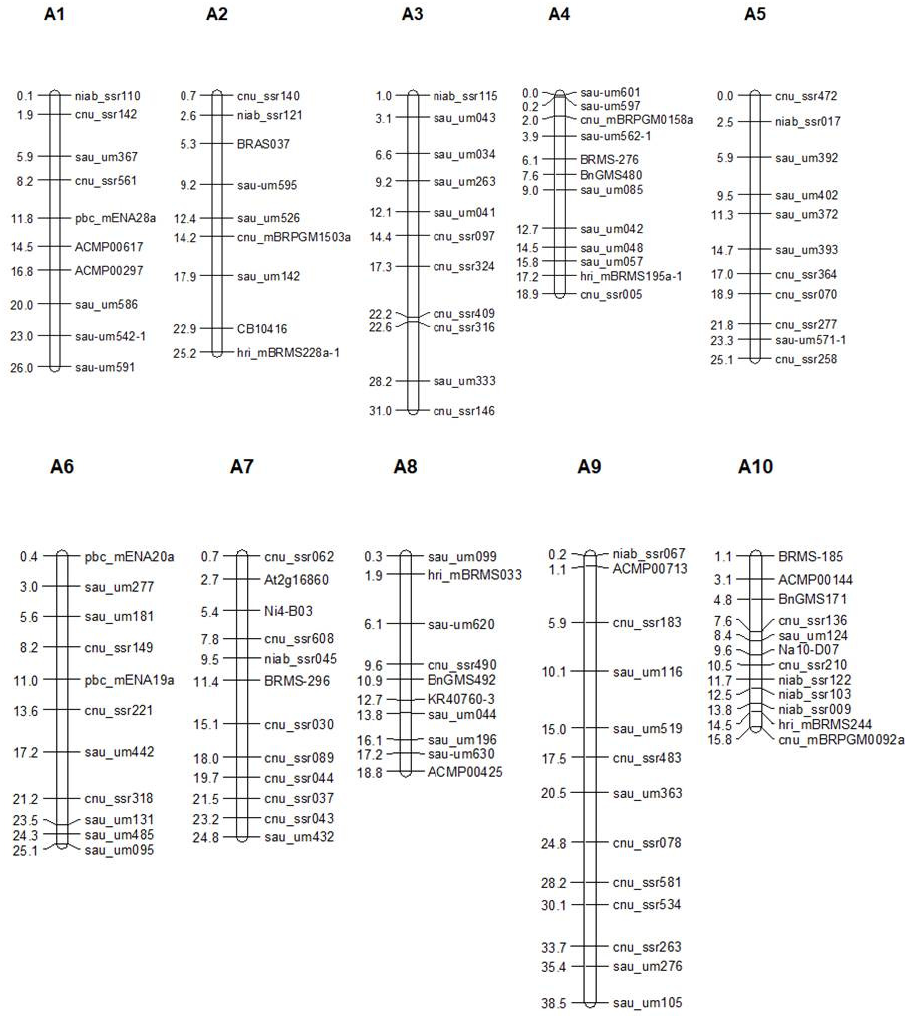
Figure 4. Distribution of 111 background selection markers on 10 B . rapa chromosomes (A1–A10).